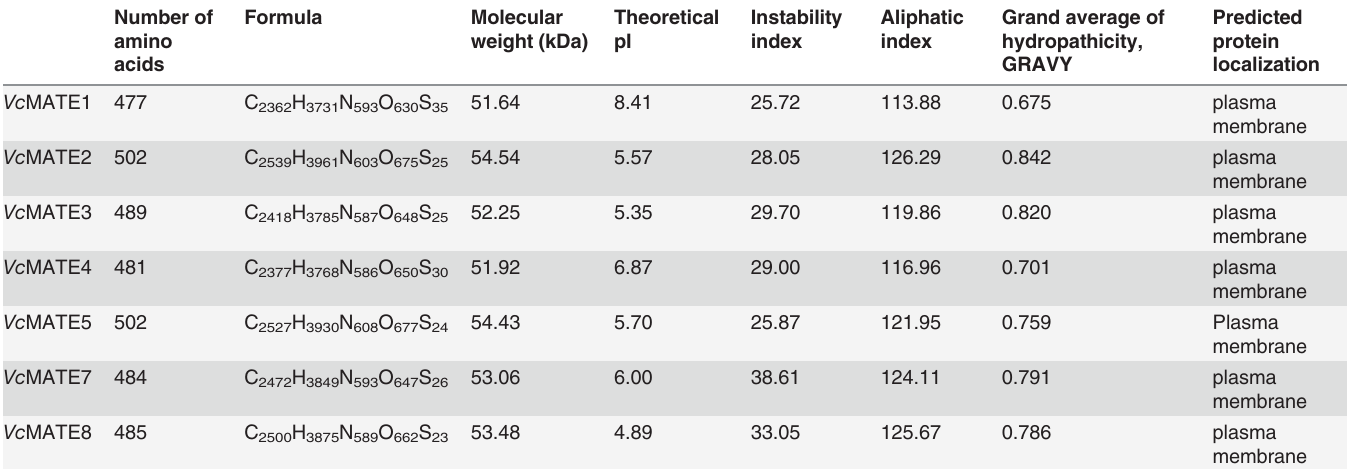
Table 3. Characteristics of the VcMATE cDNA deduced proteins. Number of amino